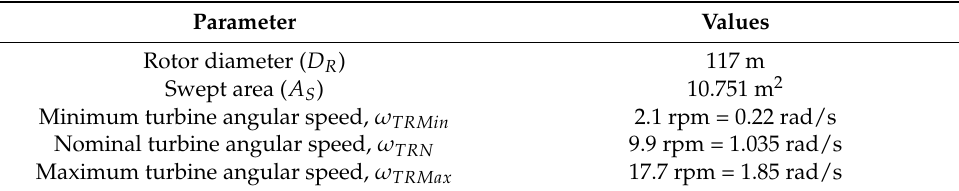
Table 1. Vestas V117-4.2 MW wind turbine and rotor data.